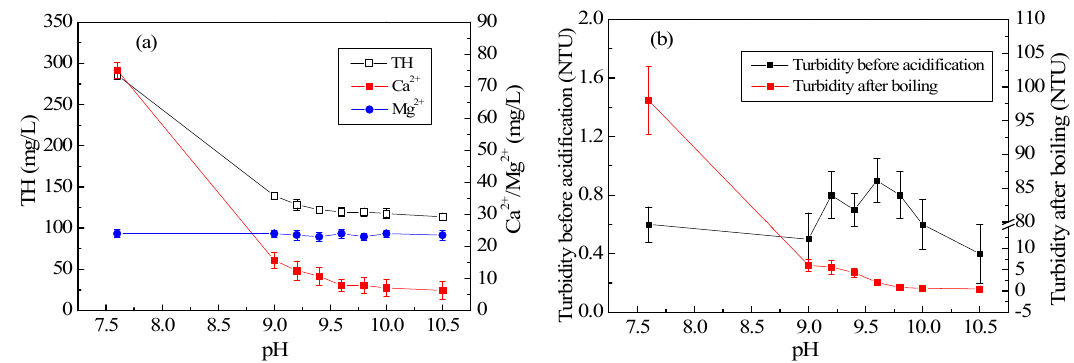
Figure 3. ( a ) Variation in TH and average concentrations of Ca 2+ and Mg 2+ with pH and ( b ) Variation in turbidity before acidification and turbidity after boiling with pH.